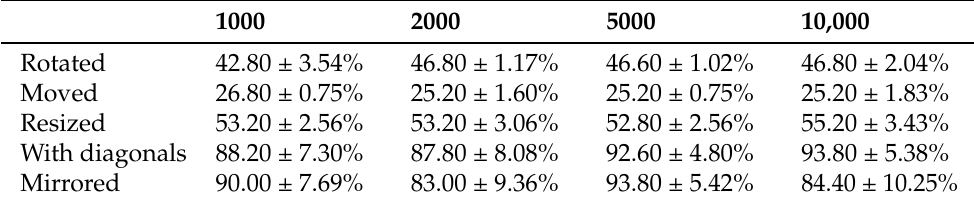
Table 4. The number of transformed objects: 0; Level of noise: